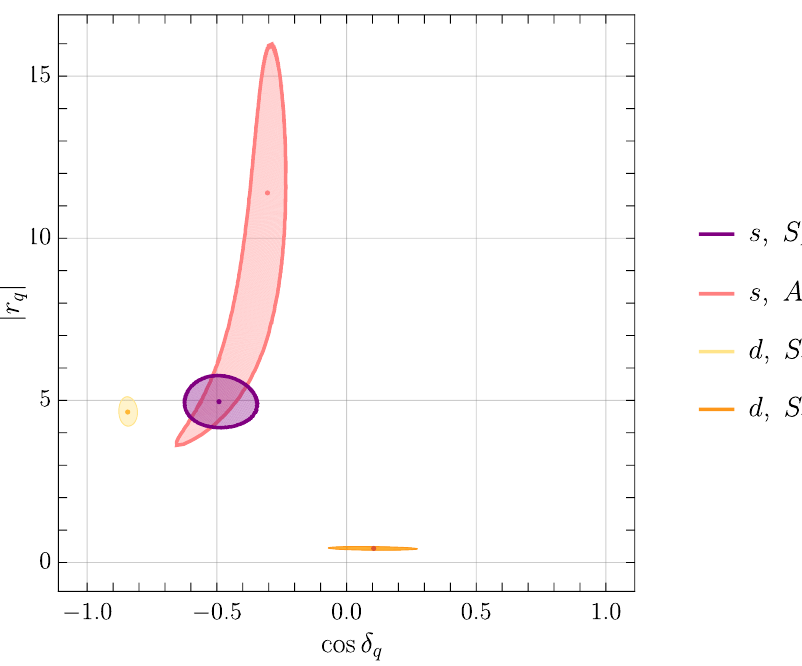
Figure 1 . The 1 σ allowed ranges for | r q | vs. cos δ q : (purple) q = s , from S KK and C KK ; (pink) and C ; (yellow) q = d , from S q = s , from A ∆Γ KK KK from S and C , for positive A ∆Γ ππ ππ ππ